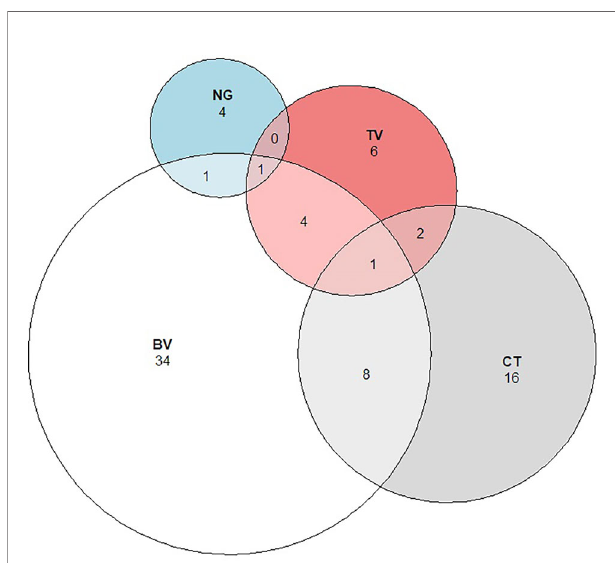
FIGURE 6 | Proportional Venn diagram showing the relationship between Bacterial vaginosis and Sexually Transmitted Infections. Legend: The fi gure above shows the number and overlap of individuals identi fi ed with Chlamydia trachomatis (CT), Neisseria gonorrhoeae (NG), Trichomonas vaginalis (TV), and Bacterial vaginosis (BV).